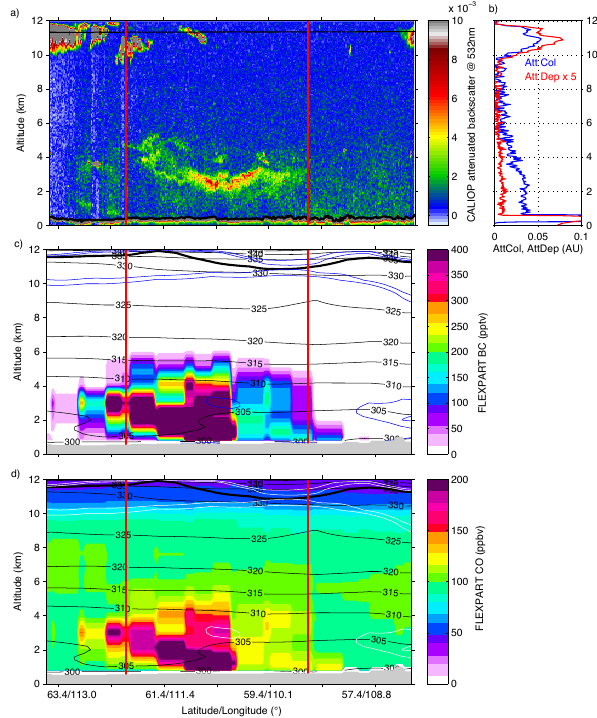
Fig. 10. As Fig. 9, but for an aerosol feature observed on 8 July 2008 19:00UTC (see Fig. 4c).